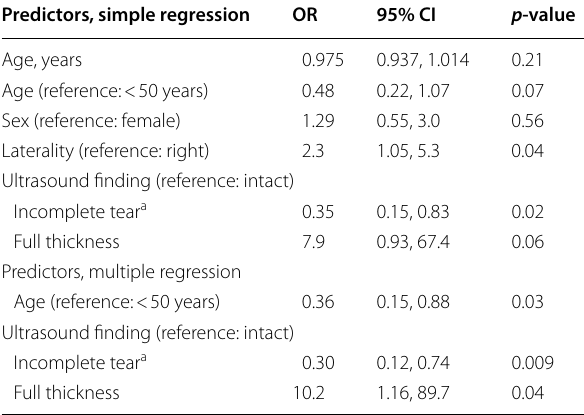
Table 3 Simple and multiple logistic regression models predicting ultrasound and MRI agreement